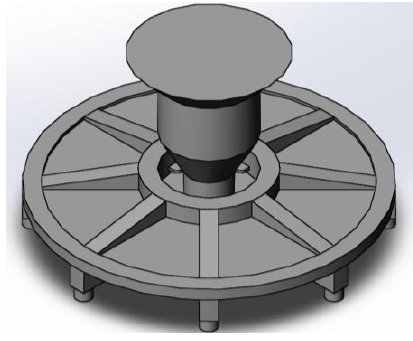
Figure 9. Three-dimensional drawing of runner system for full-size casting.